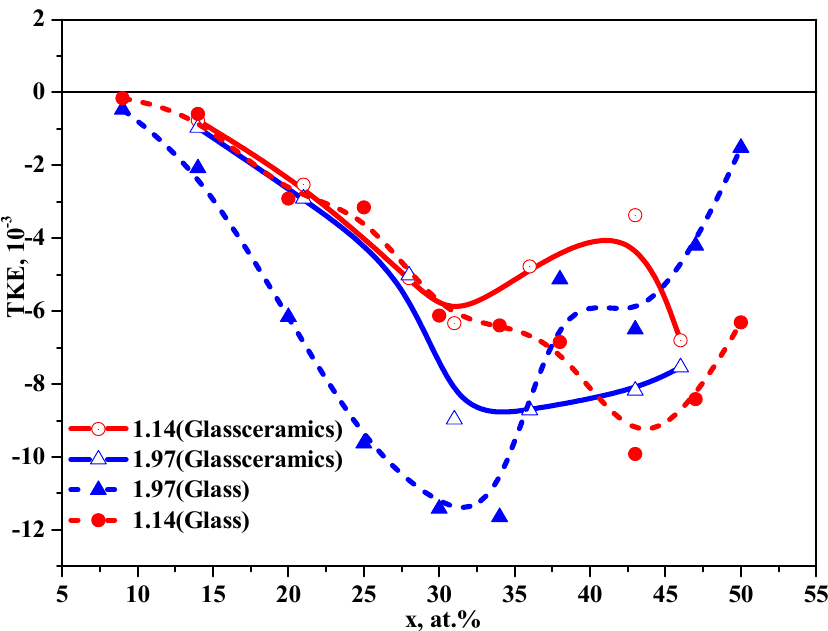
Figure 12. Comparison of the concentration dependences of TKE for nanocomposites (CoFeZr) x (MgF 2 ) 100-x on the glass and glass-ceramics substrates.